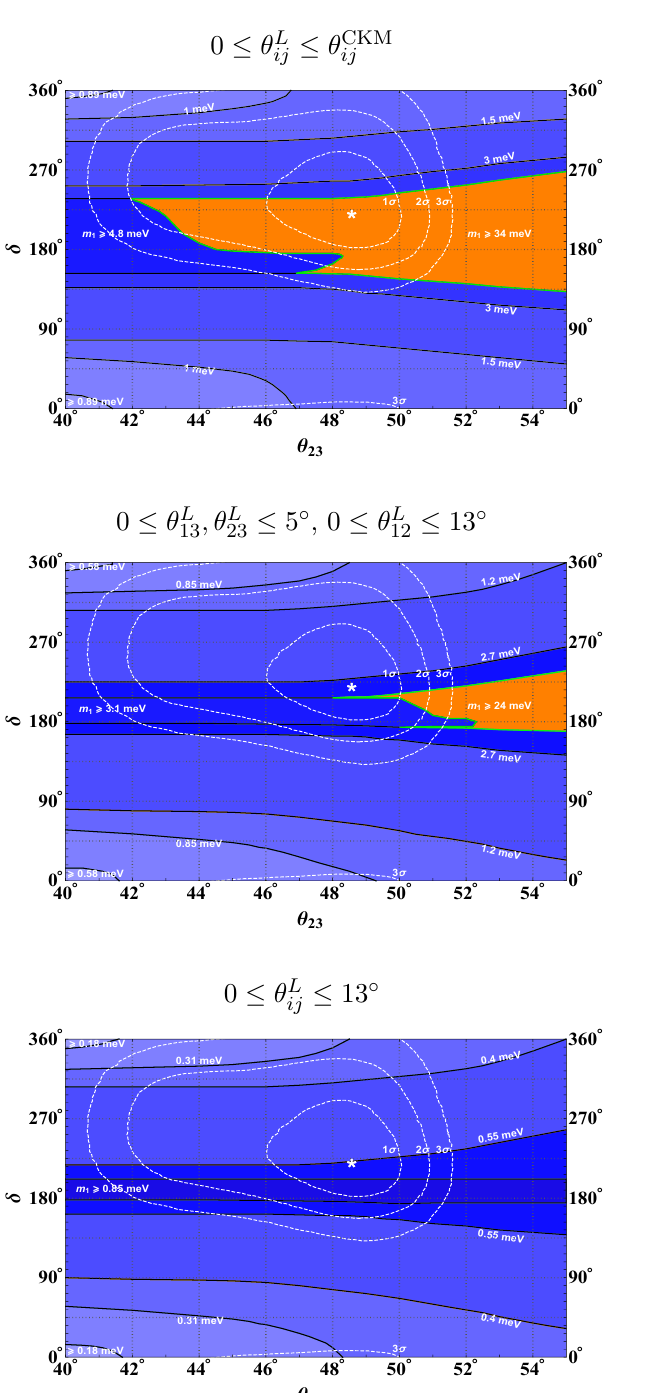
Figure 5 . Isocontour lines for the lower bound on m 1 in the plane ( (cid:18) 23 ; (cid:14) ) (same conventions as in (cid:12)gure 2) for three di(cid:11)erent choices of the upper bounds on the three mixing angles (cid:18) L case 0 (cid:20) (cid:18) L (cid:20) (cid:18) CKM (upper panel); 0 (cid:20) (cid:18) L ij ij 0 (cid:20) (cid:18) L (cid:20) 13 (cid:14) (bottom ij